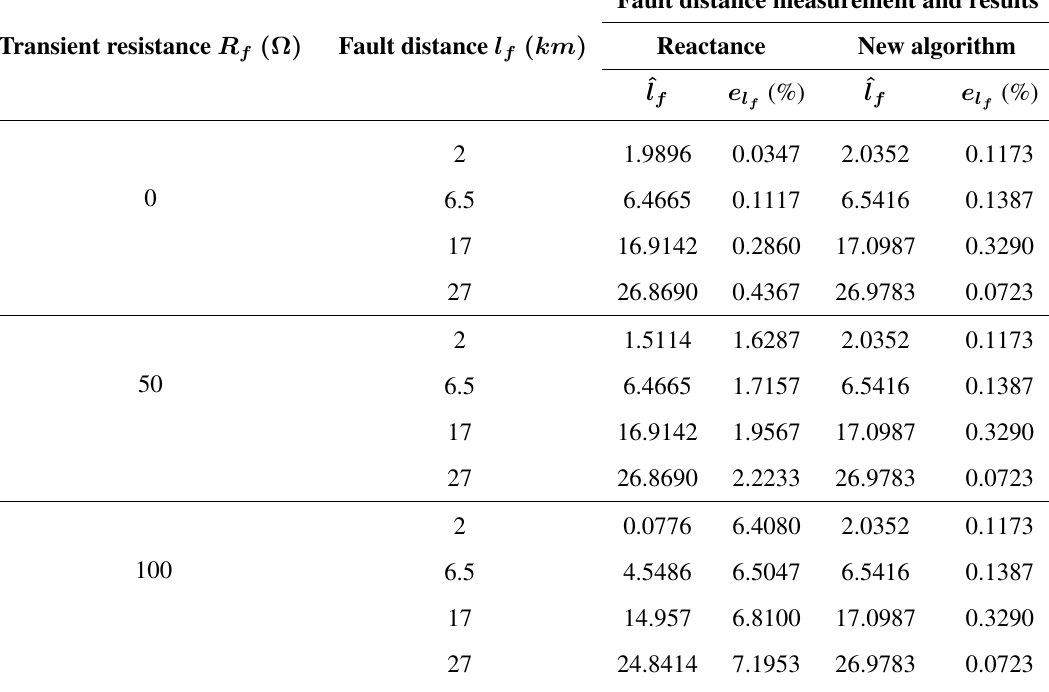
calculation when the locomotive load, Z f